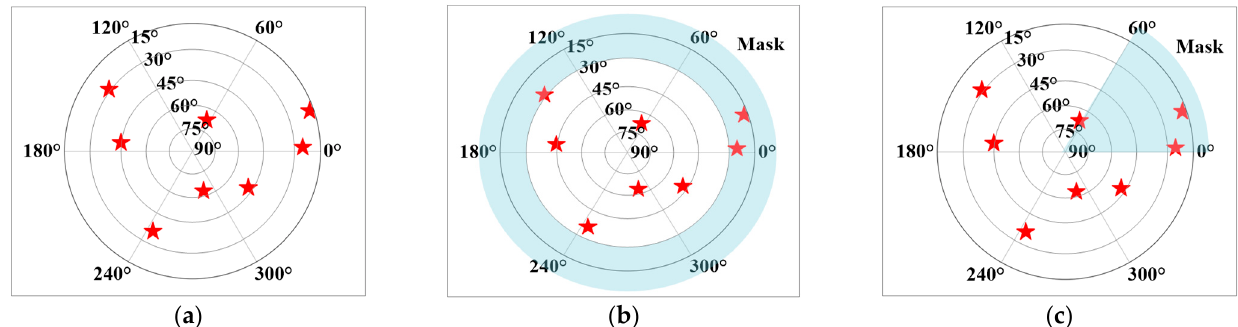
Figure 5. The sky maps of visible satellites. In the polar coordinate, the polar diameter and the polar angle refer to the elevation angle and the azimuth angle, respectively. The blue bands represent the masks of satellite observations in different conditions, ( a ) Original observations; ( b ) 30 ° elevation mask; ( c ) 60 ° azimuth mask .